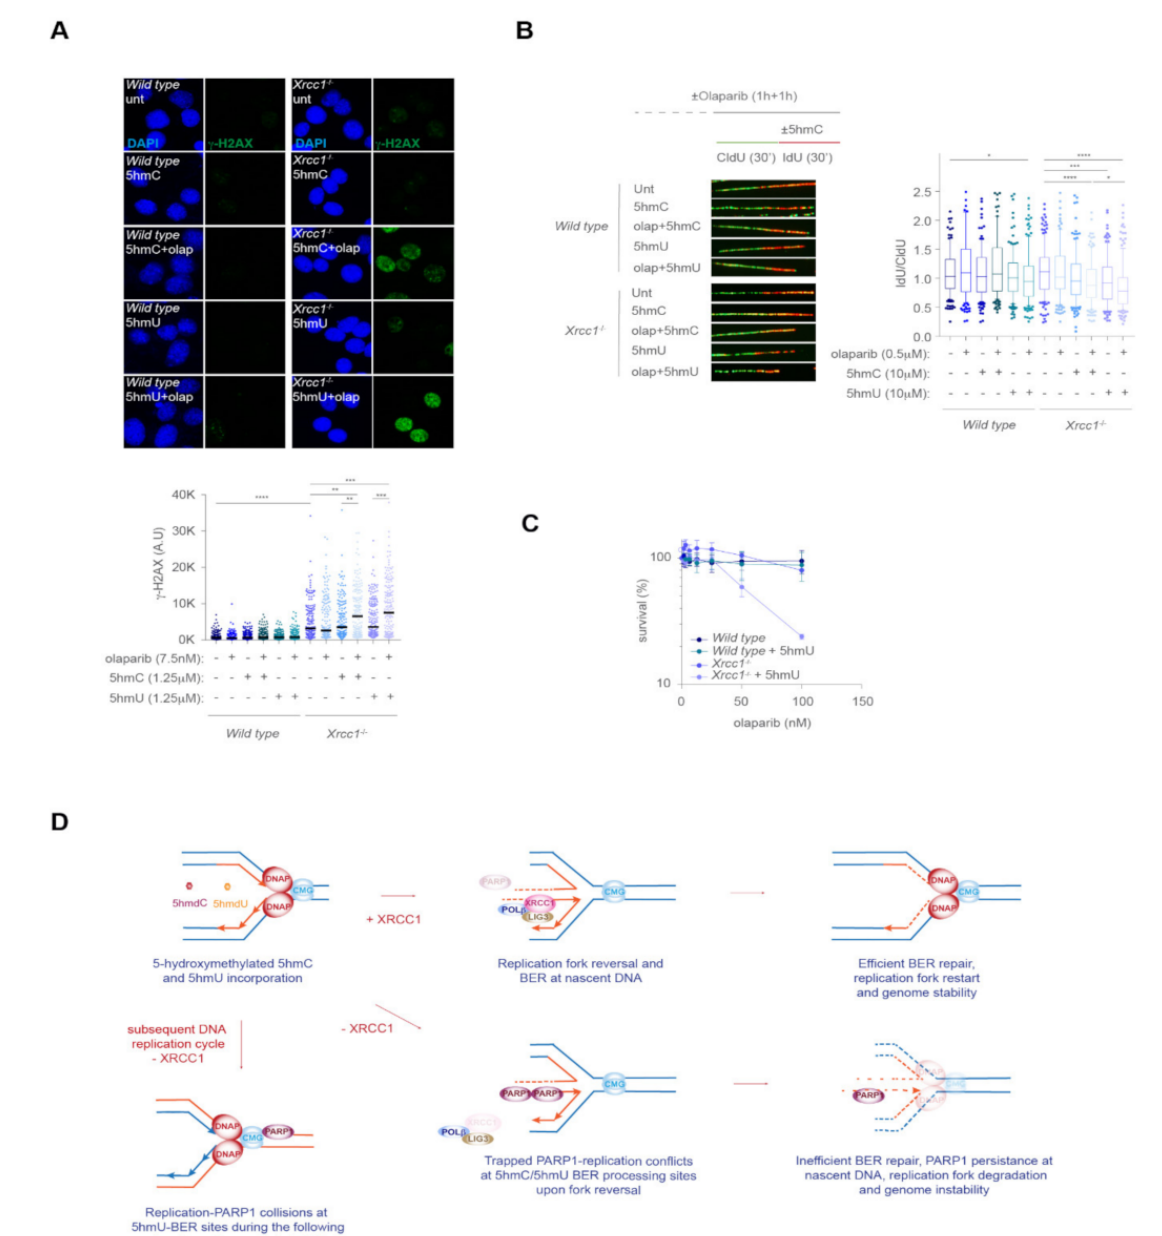
Figure 5. Trapped Parp1 by olaparib exacerbates 5hmU genomic instability in the absence of Xrcc1. ( A ) Top, representative immunofluorescence images showing γ -H2AX nuclear staining in wild type and Xrcc1 − / − MEFs after 5hmC or 5hmU (1.25 µ M) exposure alone or in combination with